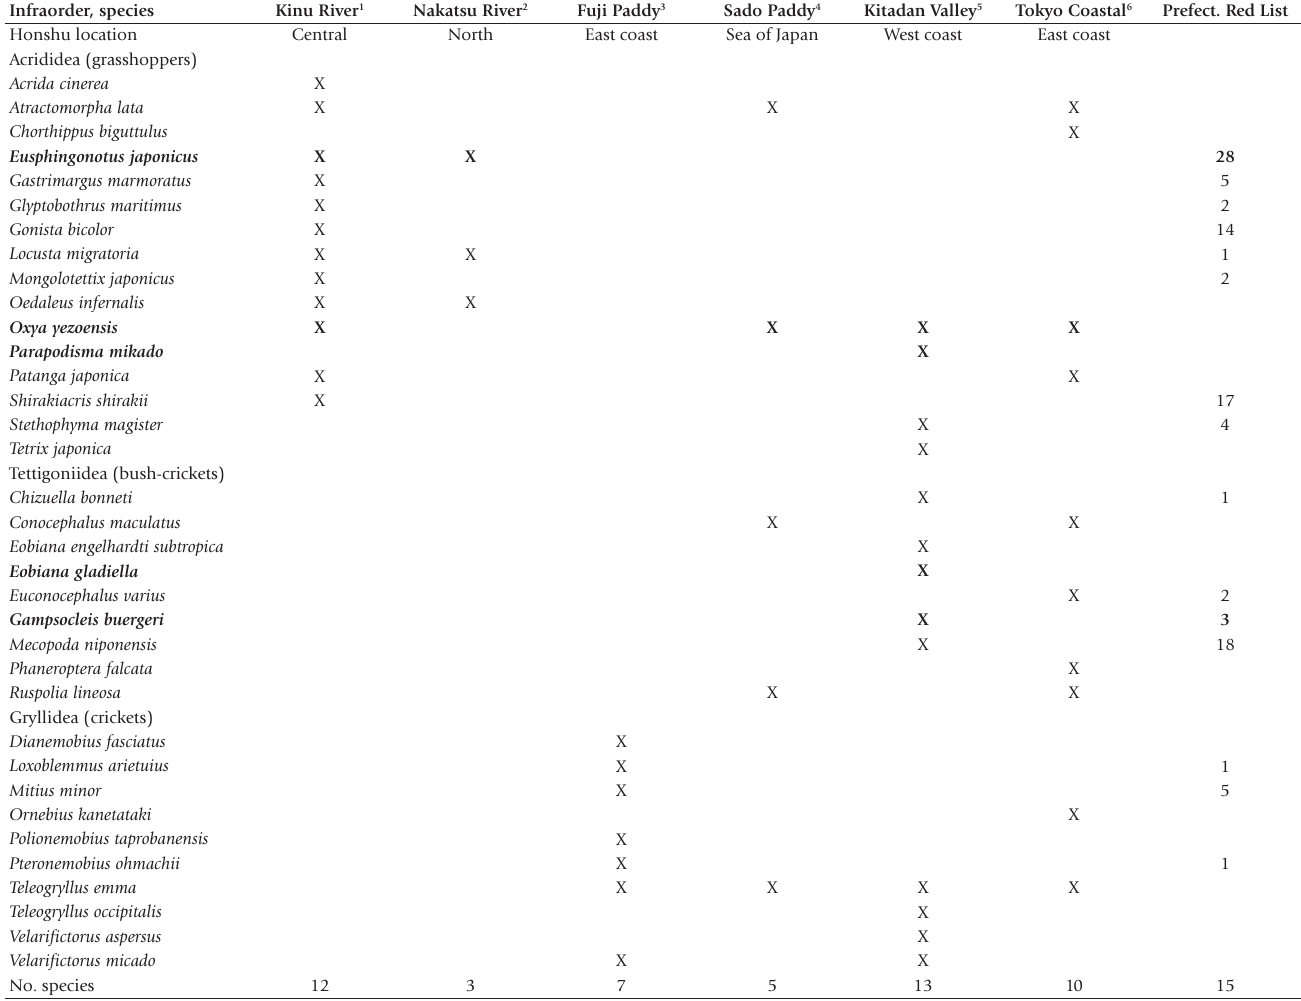
Table 2. Species of Orthoptera recorded in riparian corridors in Japan (X = recorded). Some studies only recorded one infraorder (Kinu, Nakatsu, and Fuji). The number of prefecture Red Data Lists a species is included in is also noted, and Japanese endemic species are in